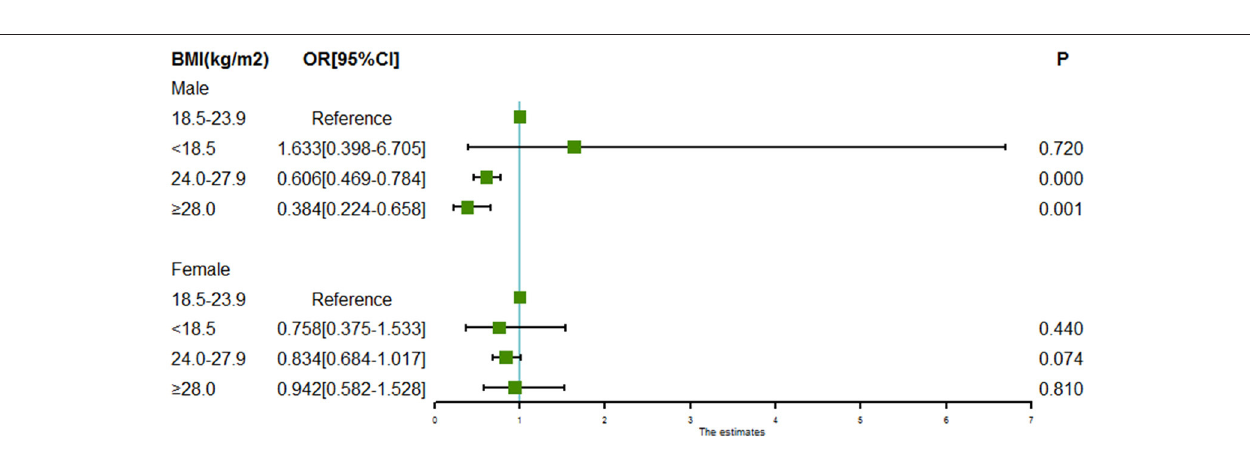
FIGURE 2 | Forest plot of ORs for the association between BMI and intracranial aneurysm rupture stratified by sex. Both the BMI 24.0 to < 28.0 kg/m 2 and the BMI ≥ 28.0 kg/m 2 were associated with a lower risk of intracranial aneurysm rupture in males. However, no association was found between BMI and intracranial aneurysm rupture in